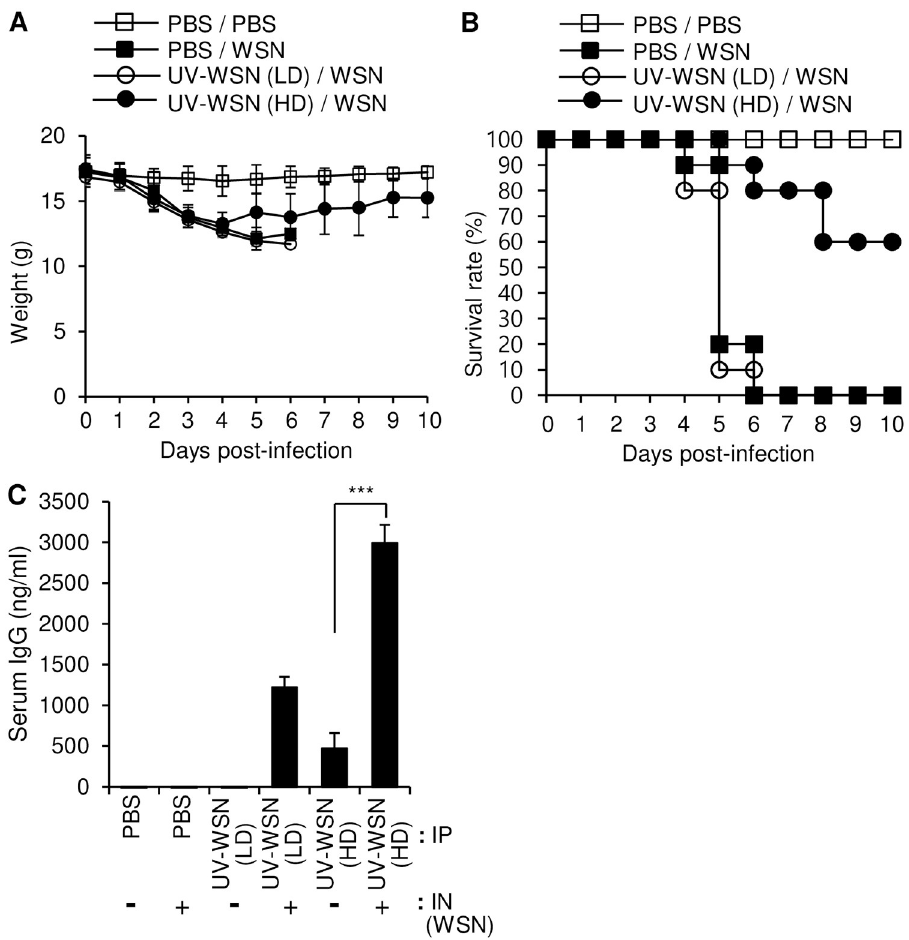
Fig 1. Intraperitoneal inoculation with a high dose of UV-inactivated Influenza A/WSN/1933 provided partial protection against lethal challenge with Influenza A/WSN/1933. BALB/c mice were inoculated intraperitoneally with 5 × 10 6 pfu (low dose, LD) or 5 × 10 7 pfu (high dose, HD) of UV-inactivated Influenza A/WSN/1933 (UV-WSN). At day 14 post inoculation, the mice were challenged intranasally with 10 LD 50 of live Influenza A/WSN/1933 (WSN). (A, B) Survival (A) and body weight (B) were evaluated over a 10-day period after the challenge (n = 10/group). (C) Blood samples were collected at day 14 after initial intraperitoneal inoculation or at day 5 after intranasal challenge, and amounts of WSN-specific IgG in sera were determined by ELISA (n = 5/group). ��� p < 0.001. Php did not confer any protection against weight loss or mortality after intranasal challenge with WSN (Fig 2A and 2B). Morbidity was further confirmed in the mice inoculated with H3N2 Php by an abnormal husky red color, increased viral load, severe alveolar damage, and invasion by inflammatory cells within lung tissues (Fig 2C–2E). The serum levels of WSN-spe- cific IgG 5 days after the intranasal challenge were higher in the mice that were pre-inoculated with WSN than in control mice that were injected with PBS prior to the intranasal challenge (Fig 2F, left panel). By contrast, no WSN-specific IgG was detected in the mice that were pre- inoculated with H3N2 Php (Fig 2F, left panel), although these mice did produce high levels of H3N2 Php-specific IgG (Fig 2F, right panel). When the mice pre-inoculated with H3N2 Php was intranasally challenged with WSN, WSN-specific IgG was produced with a level similar to that of the WSN-inoculated mice. Importantly, WSN challenge alone did not induce detectable production of WSN-specific IgG in the PBS control mice. Therefore, H3N2 Php inoculation is